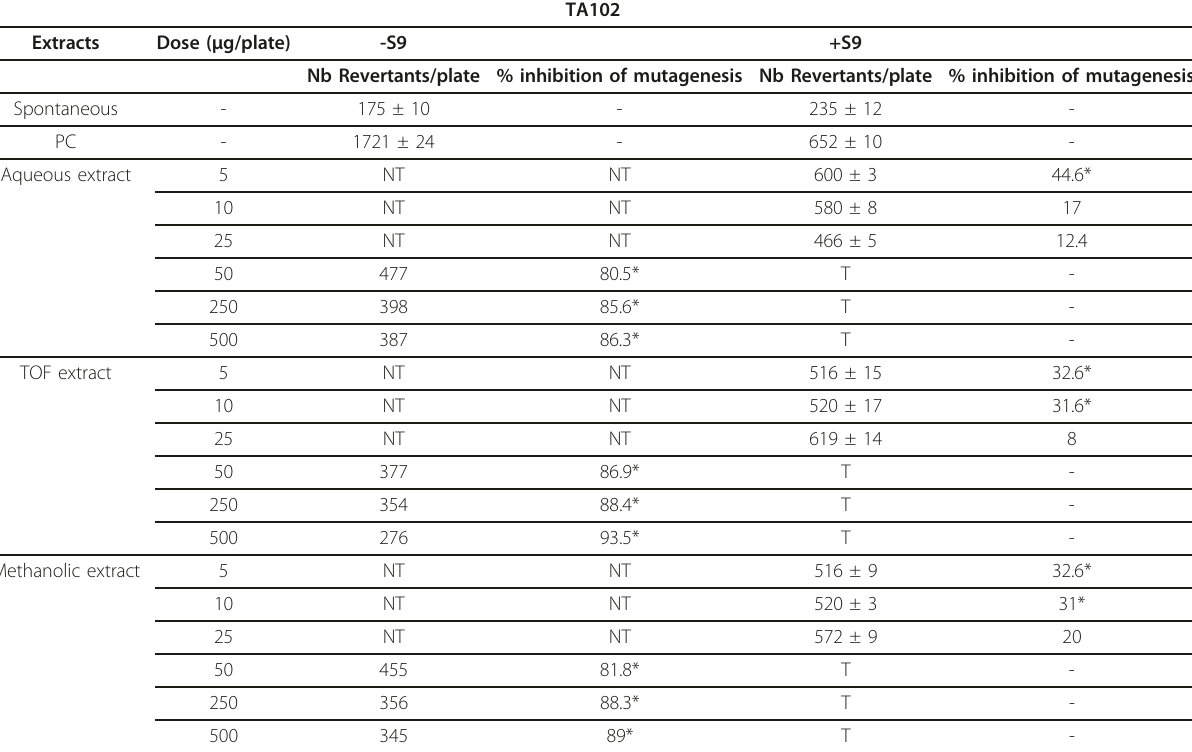
Table 5 Effects of extracts from A. salicina on the mutagenicity induced by MMS and 2-AA in S. typhimurium TA102 assay system respectively in the absence and in the presence of